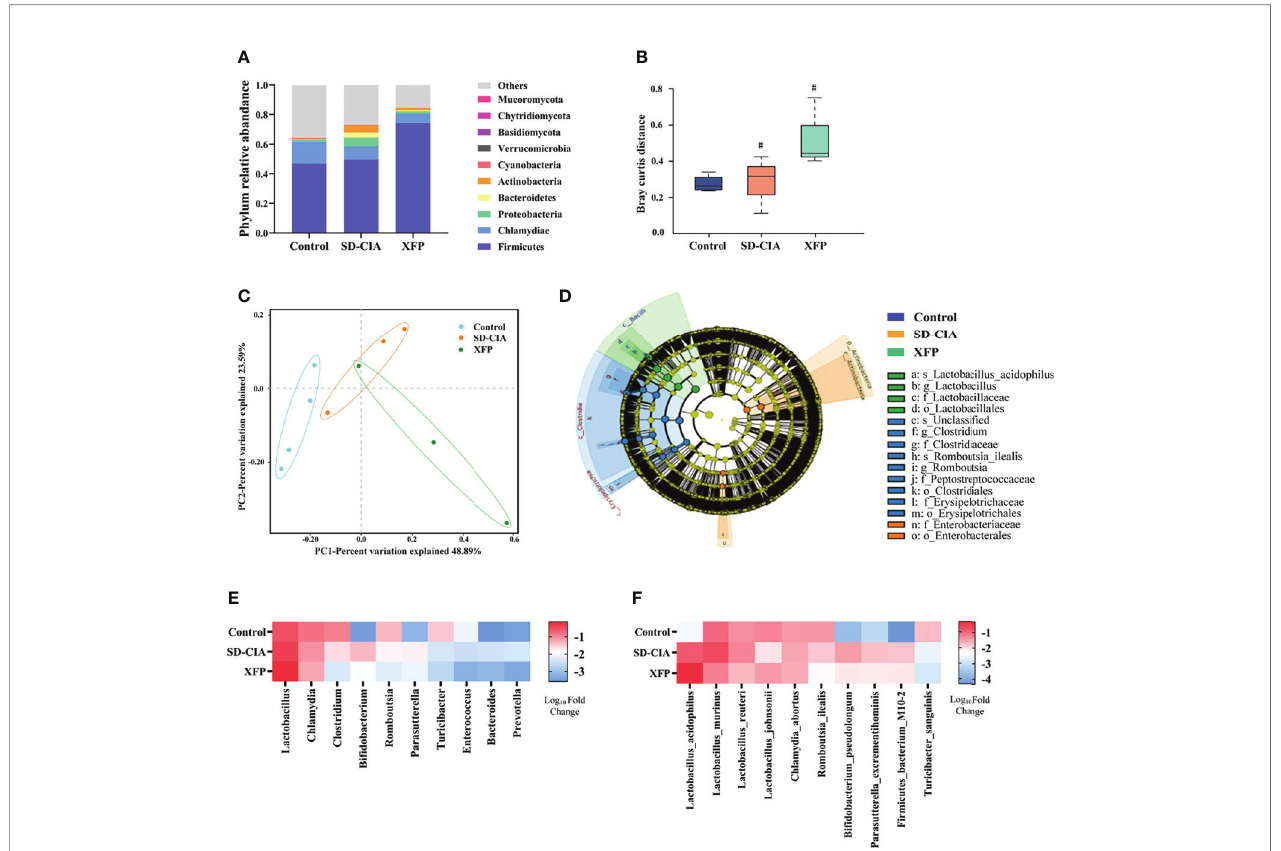
FIGURE 6 | Effect of XFP on gut microbiota distribution in the ileum. (A) Relative abundance of the top 10 most abundant phyla in each group. (B) Boxplot of species composition based on Anosim. Data are presented as the medians (IQRs). (C) Differences in gut microbial communities among the groups as determined by PCoA. (D) The evolutionary branching diagram of gut microbiota using LEfSe analyses. Relative abundances among the groups at the genus (E) and species (F) levels. The data were transformed by log (10) . N = 4 (control), N = 3 (SD-CIA and XFP). # P < 0.05 compared to the control group. XFP, Xiong Fu powder; CIA, collagen-induced arthritis; SD, spleen de fi ciency; SD-CIA, collagen-induced arthritis with spleen de fi ciency; IQR, interquartile range; Anosim, analysis of similarities; PCoA, principal coordinates analysis; LEfSe, linear discriminant analysis effect